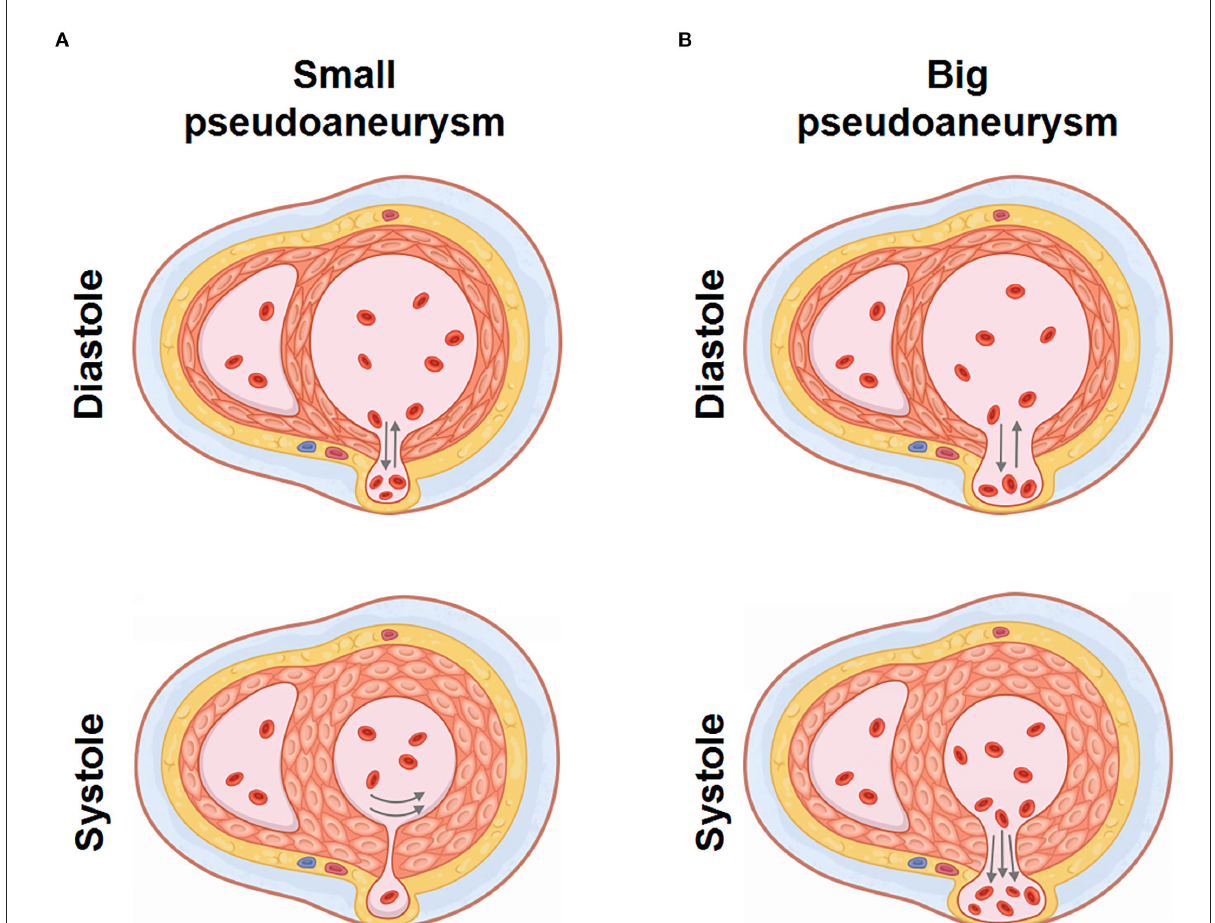
FIGURE3 Hemodynamic characteristics of LV pseudoaneurysm with different shapes. (A) Hemodynamic diagram of small LV pseudoaneurysm with narrow fissure. (B) Hemodynamic diagram of big LV pseudoaneurysm with wide